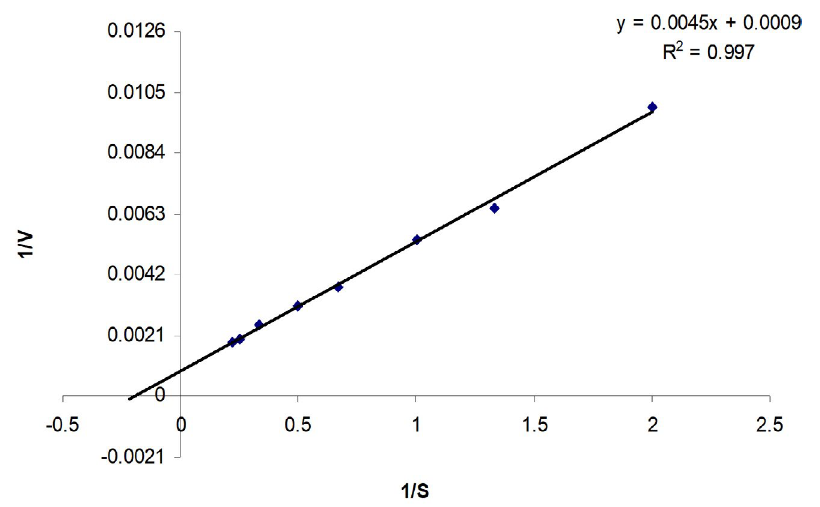
Fig. 4. Reciprocal velocity plot (Lineweaver-Burk’s plot) of purified β-mannanase activity as a function of locust bean gum